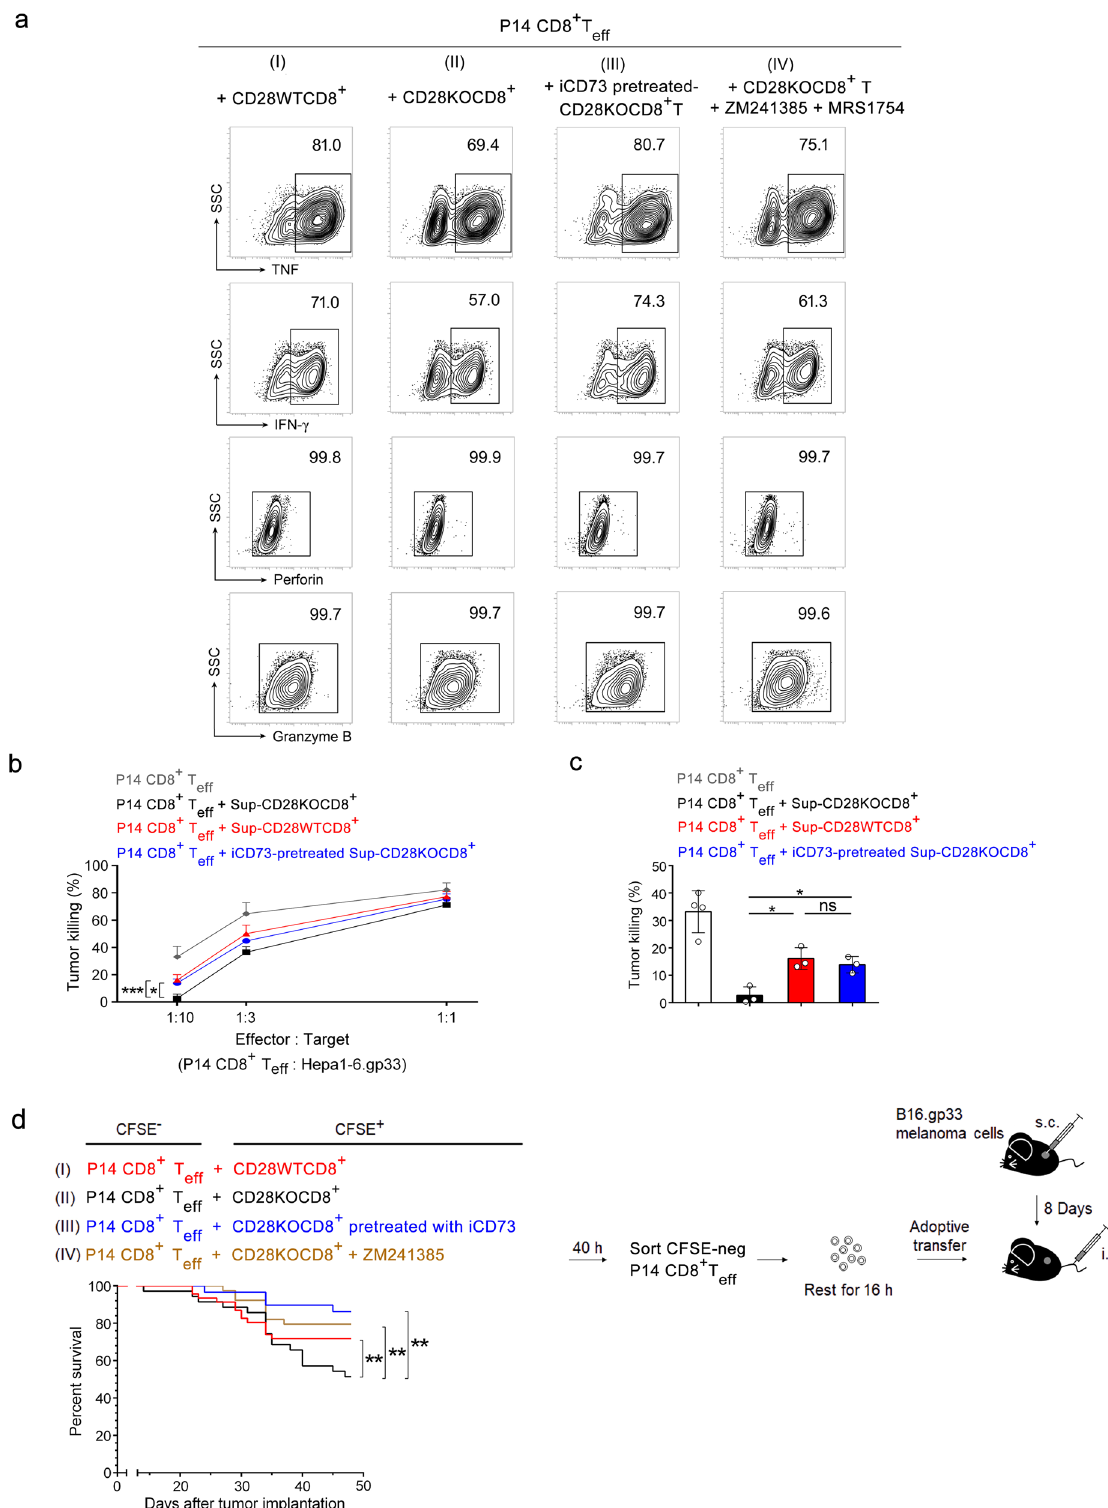
ipheral blood express CD73 but CD73 expression on CD28 − CD8 + T cells, is signi fi cantly increased after cell in fi ltration into the tumor as compared to that on CD28 + CD8 + T cells (Fig. 5c, d). It is our speculation that when stimulated by tumor antigen in the absence of CD28 signaling in the tumor microenvironment and in lym- phoid tissues, CD8 + T cells upregulate the expression of